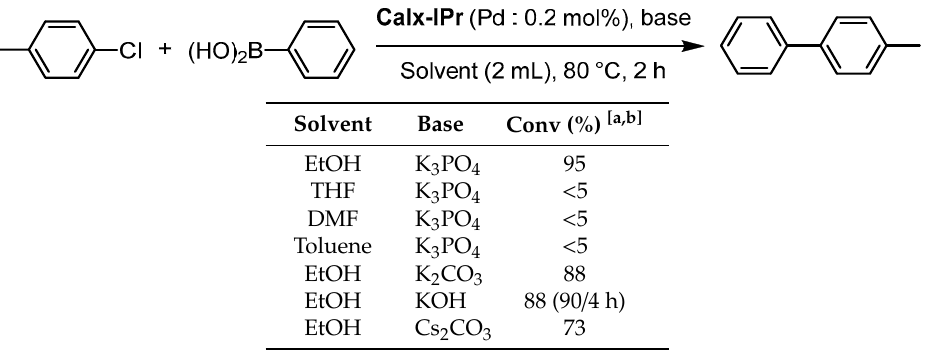
Table 2. Optimization of solvents and bases in Suzuki–Miyaura cross-coupling reactions catalyzed by Calx-IPr.